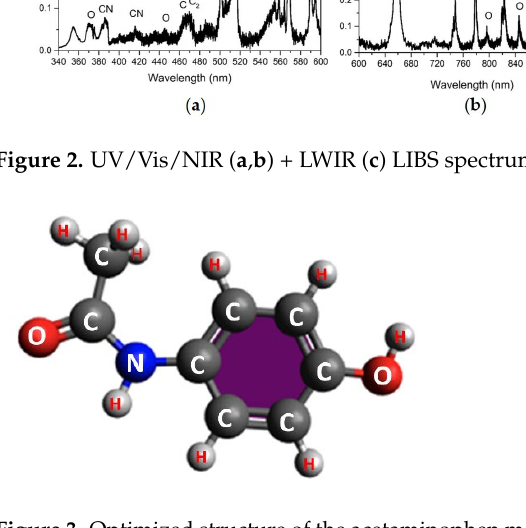
Figure 3. Optimized structure of the acetaminophen molecule calculated with DFT(BP86)/def2-TZVP using ORCA. Table 1. Vibrational mode assignments of the acetaminophen LWIR LIBS bands.